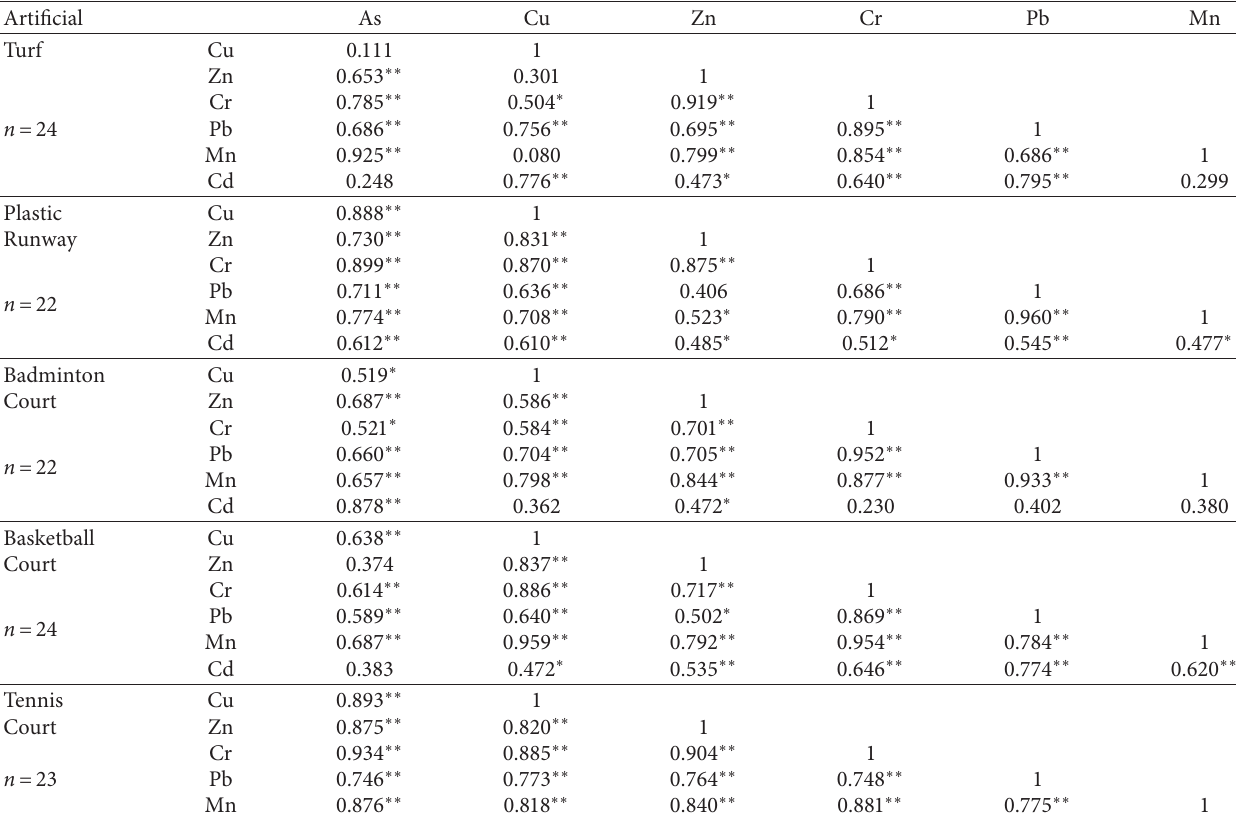
Table 4: Pearson’s correlation coefficients for correlation between seven metals and metalloid concentrations in athletic field runoffs.